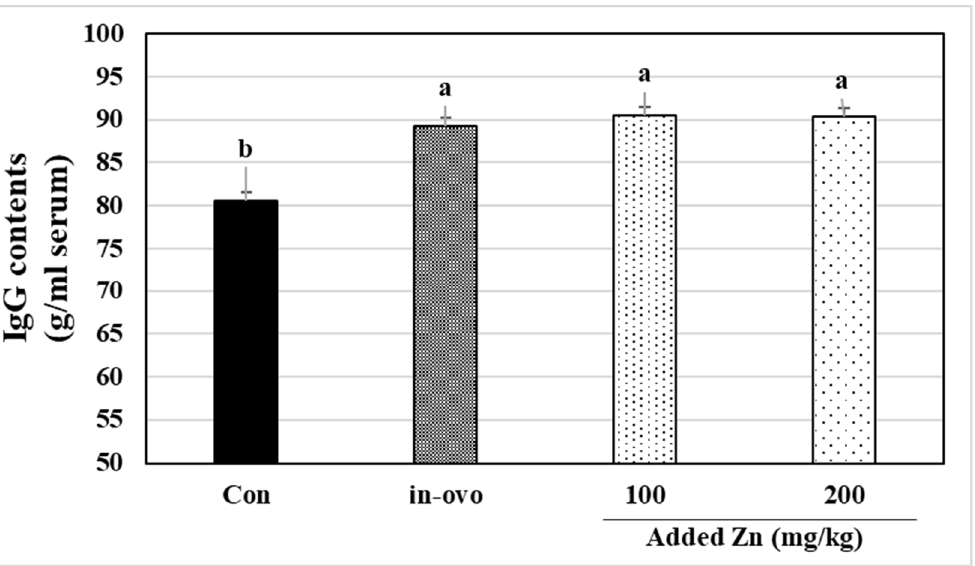
Figure 1. Effect of in ovo injected and supplemental Zn on IgG of blood in broilers at 35 days of age. a,b Means in treatment with different superscripts are significantly different ( p < 0.05).